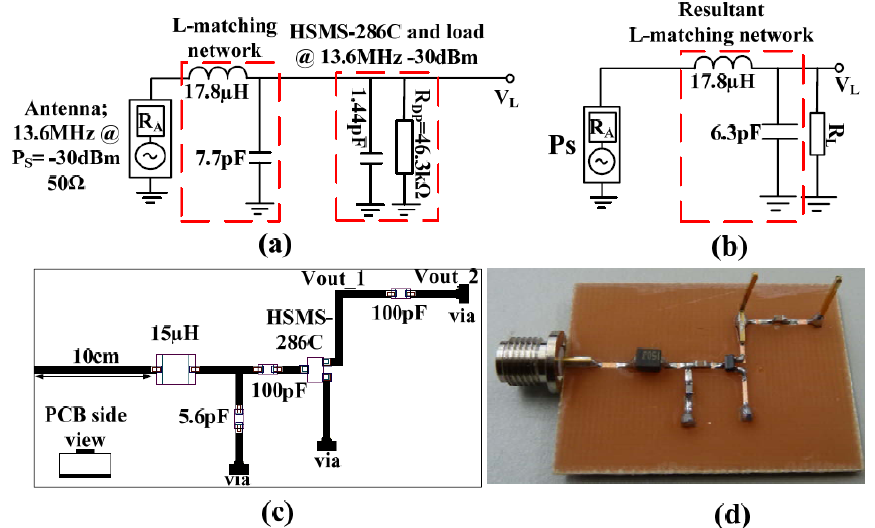
Figure 14. ( a ) L-matched impedance diagram for matching the HSMS-286C diodes at 13.6 MHz at -30 dBm input. ( b ) Resultant network, ( c ) PCB layout of the